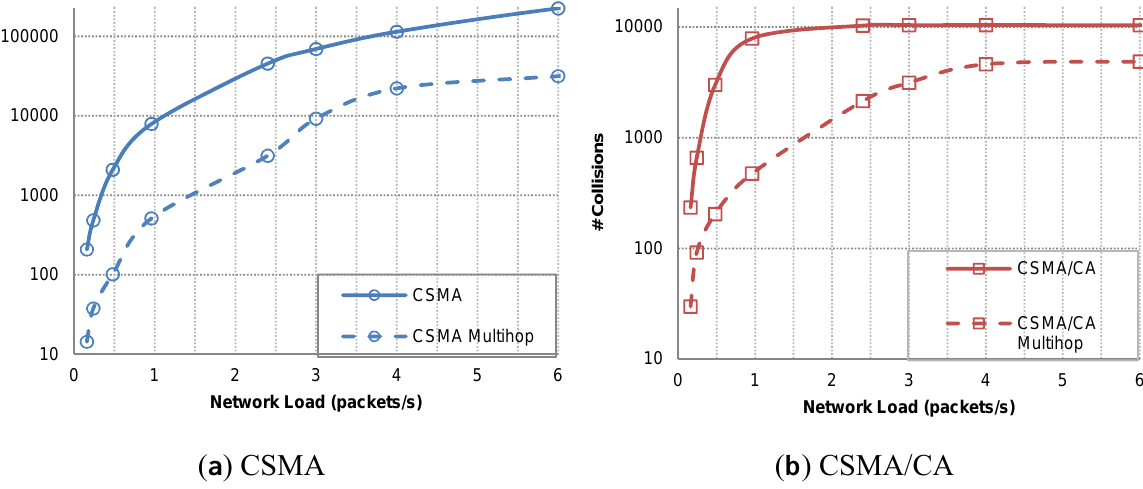
Figure 14. Collisions one hop vs .